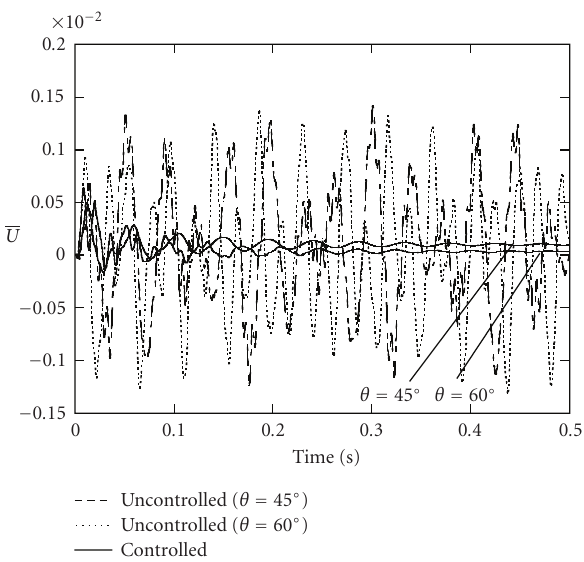
Figure 17: Influence of ply angle on the uncontrolled/controlled nondimensional lagging deflection time-history of the blade sub- jected to the step loading with σ = 1, β o = γ = 0, and Ω = 100rad/s.